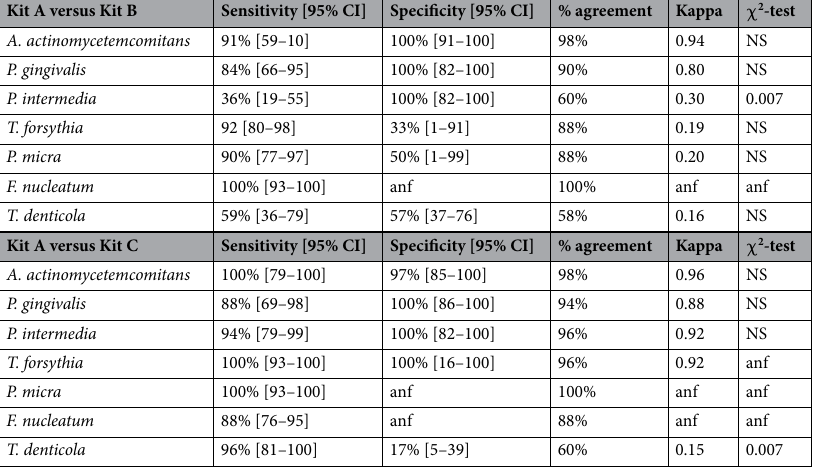
Table 6. Taking Test Kit A as the benchmark, sensitivity, specificity, together with 95% confidence intervals and % agreement and kappa values are computed for the presented microorganism in relation to either Kit B or Kit C. Significant p-values for McNemar test χ 2 -test are given (Bonferroni correction for multiple comparisons) ( NS not significant; anf analysis not feasible—due to the number of ‘zeros’ in the